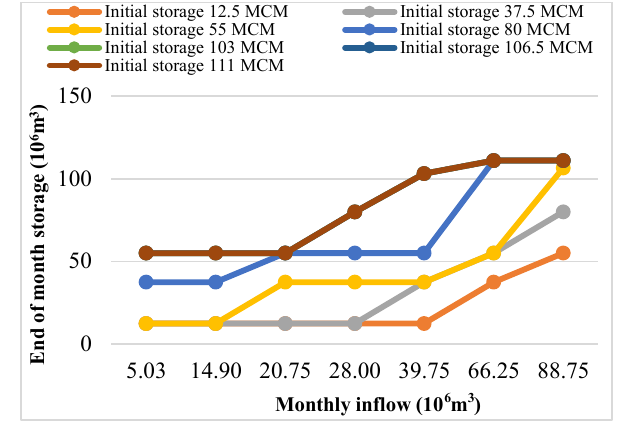
Figure 4. Muzhwi March Rule curve. Figure 5. Siya February Rule